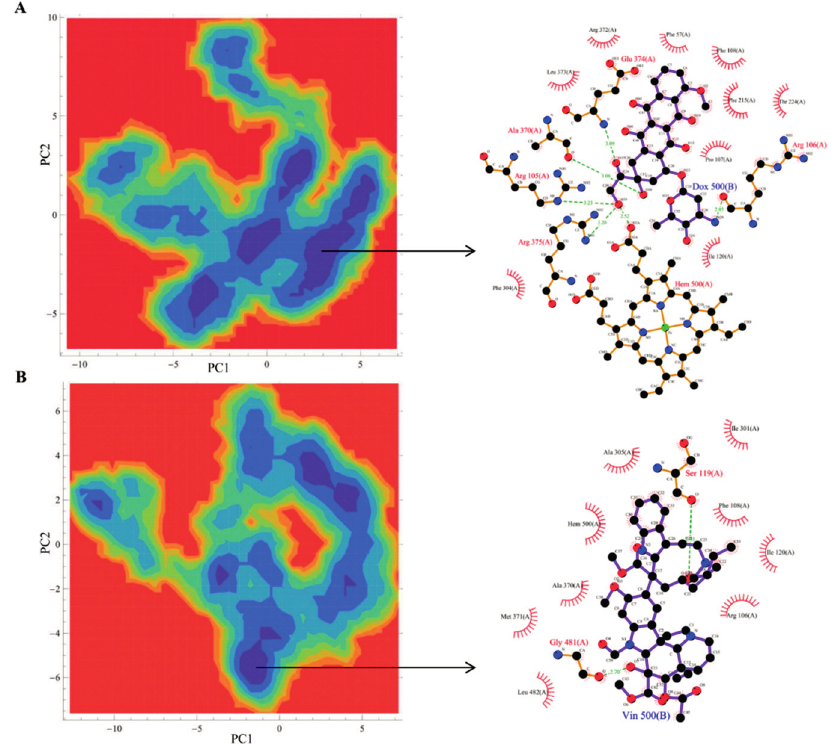
Figure 7. FEL and the representative lowest energy conformation of simulated drugs. The FEL of the simulated complexes based on the principal component analysis. ( A ) Doxorubicin; ( B ) vincristine. Each representative structure is displayed from the most populated free energy minimum clusters using